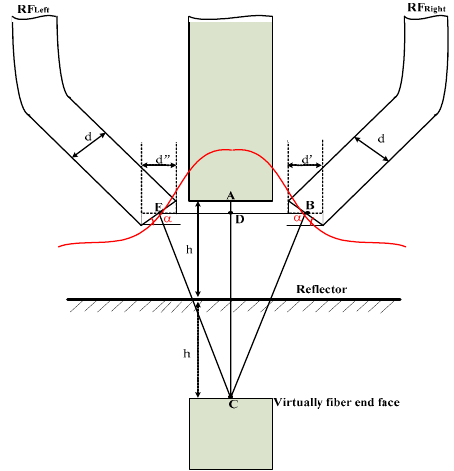
Figure 2. Geometry of the light intensity modulation mechanism.